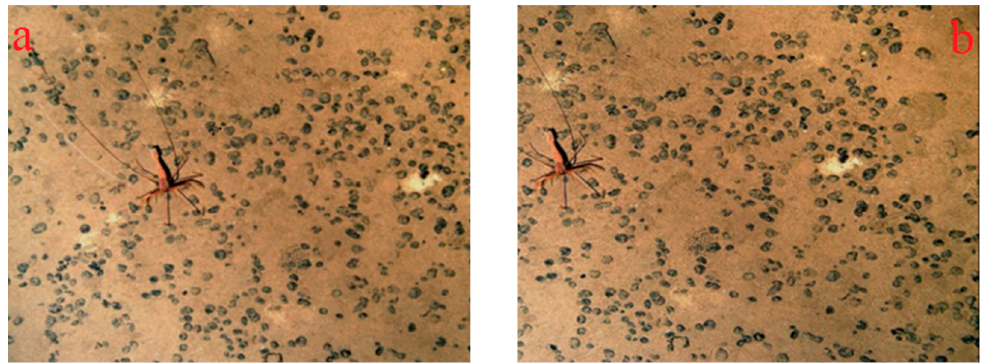
Figure 11. The original images for T3: ( a ) Reference image [21]; ( b ) Be-registered image.